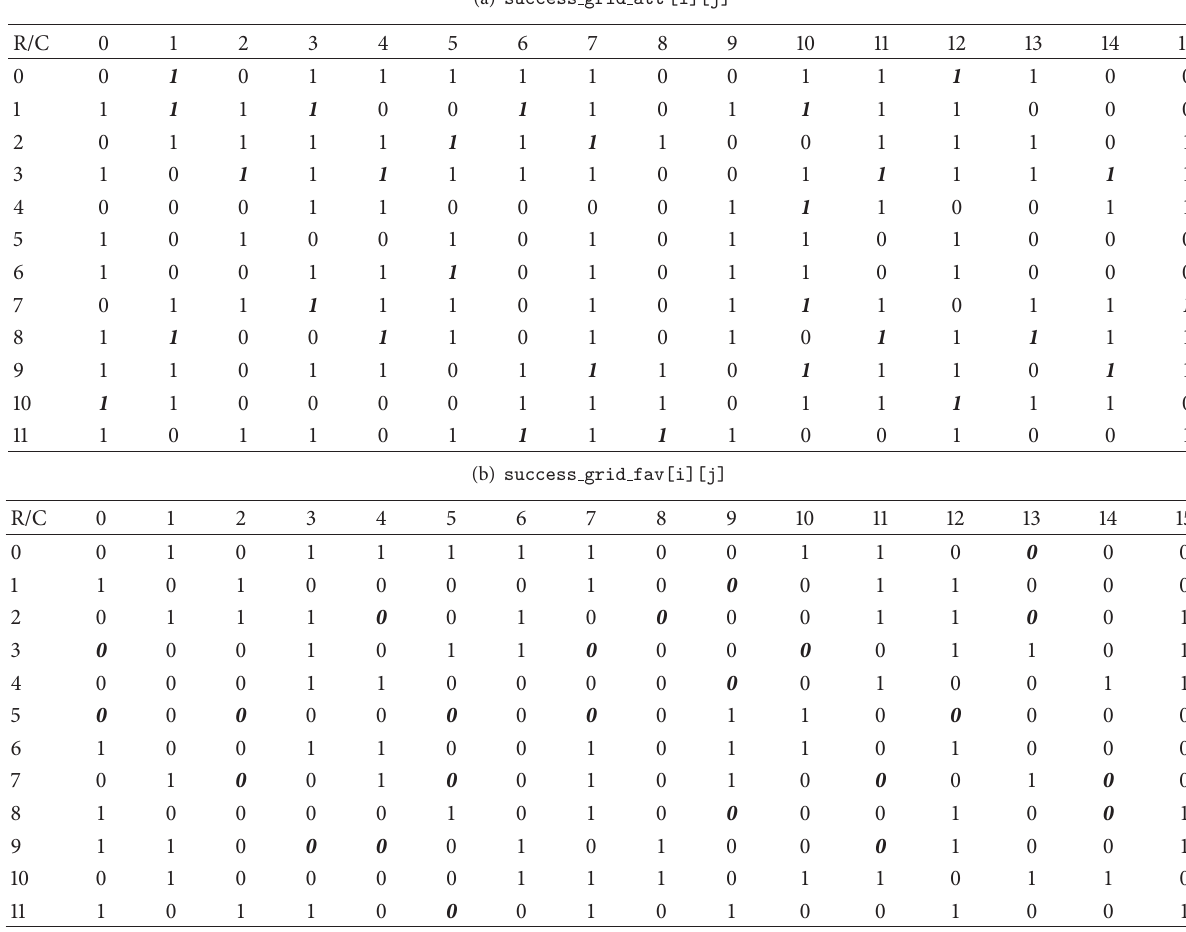
Table 3: Grids obtained by comparison: success grid att [i][j] and success grid fav[i][j]